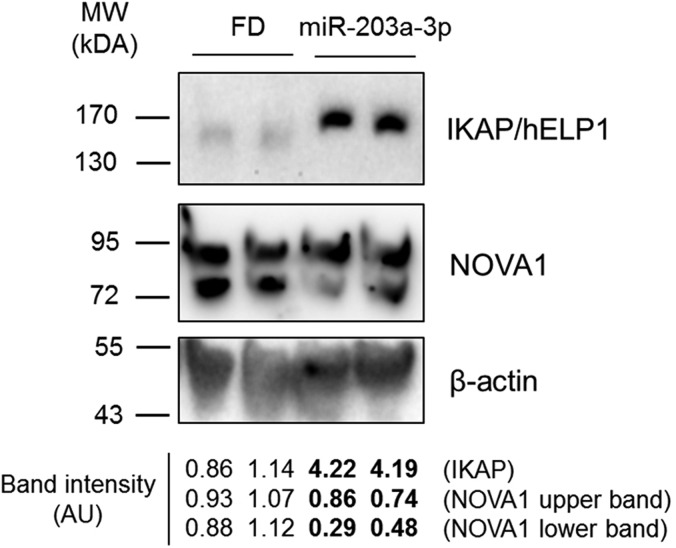
miR-203a-3p overexpression downregulates NOVA1 and upregulates IKAP protein levels. Western blotting shows expression level of IKAP and NOVA1 proteins in one culture of FD hOE-MSCs and one FD clone overexpressing miR-203a-3p. β-actin expression level was used as a housekeeping protein. A quantification of the band intensity is shown.